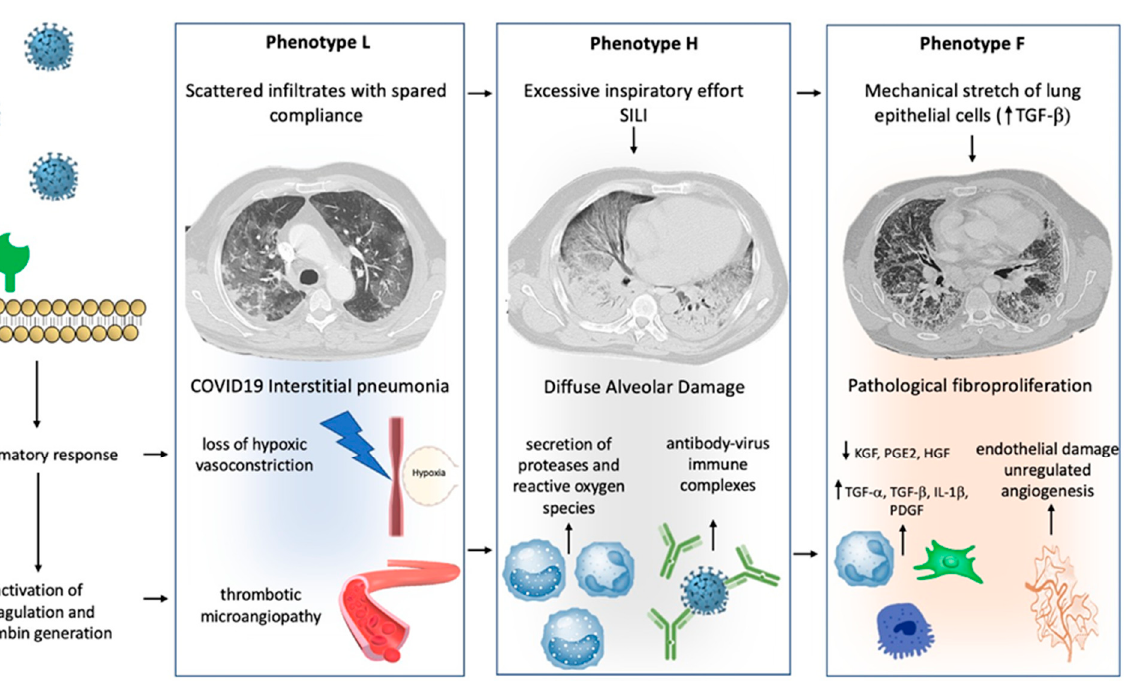
Figure 1. Mechanisms of progression between phenotype: Different hypothetical mechanisms, involving physical stimuli and biological modifications, can determine the progression between COVID-19 phenotypes. Progression from type L to type H may result from excessive inspiratory effort (SILI) and from recruitment of neutrophils into the lung parenchyma with secretion of proteases and reactive oxygen species. Furthermore, a role of activation of Fc receptors immune cells through antibody-virus immune complexes has been hypothesized. Progression from type H to type F results from damage to the scaffolding of the lung and vascular lesions with disorganized repair and imbalance between profibrotic and antifibrotic mediators. Physical factors, such as lung parenchyma stretch, may also contribute via transforming growth factor-beta (TGFB) secretion. See the text for more details.